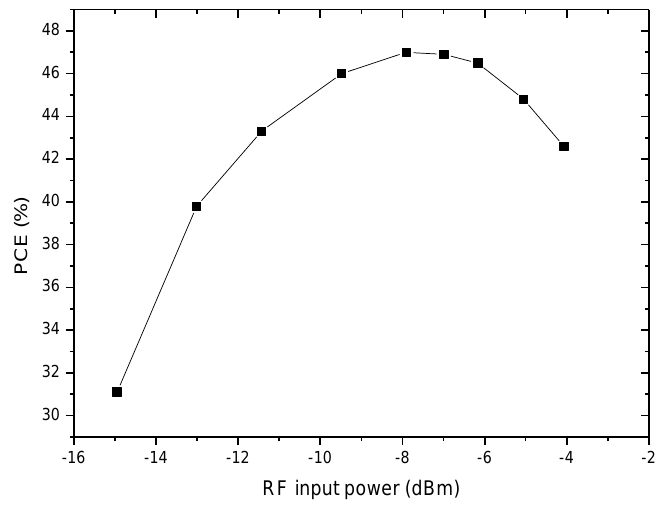
Figure 14. PCE of the 3-stage rectifier with different input